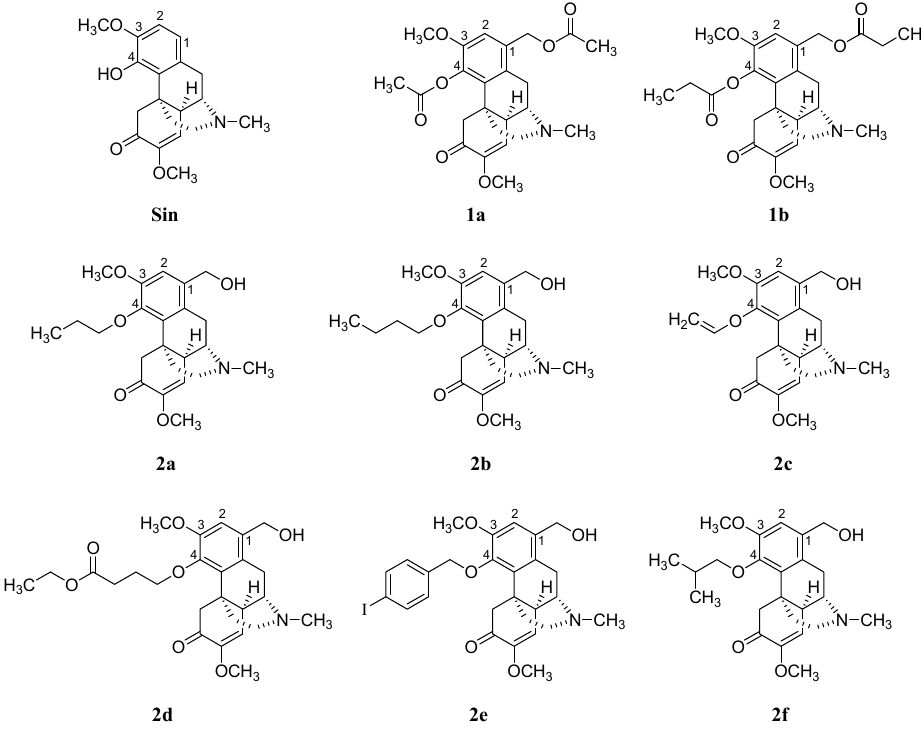
Figure 1. Chemical structures of Sin and its new derivatives ( 1a – 2f ).